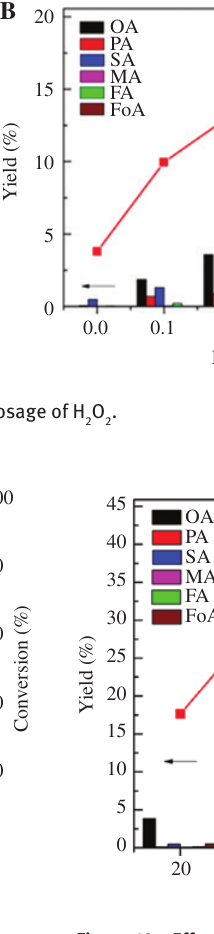
Figure 10: Effect of the amount of CuFeS